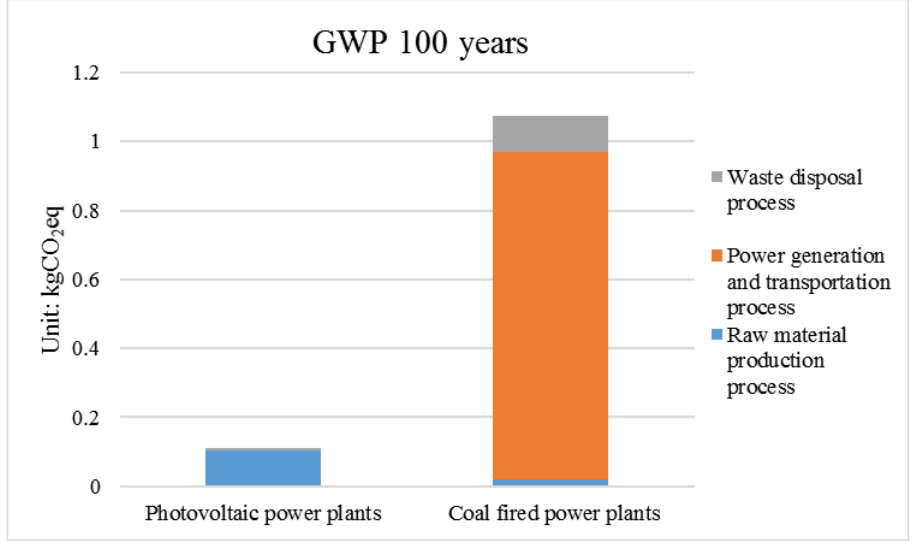
Figure 6. Comparison of global warming potential in coal-fired power plants and photovoltaic power plants.